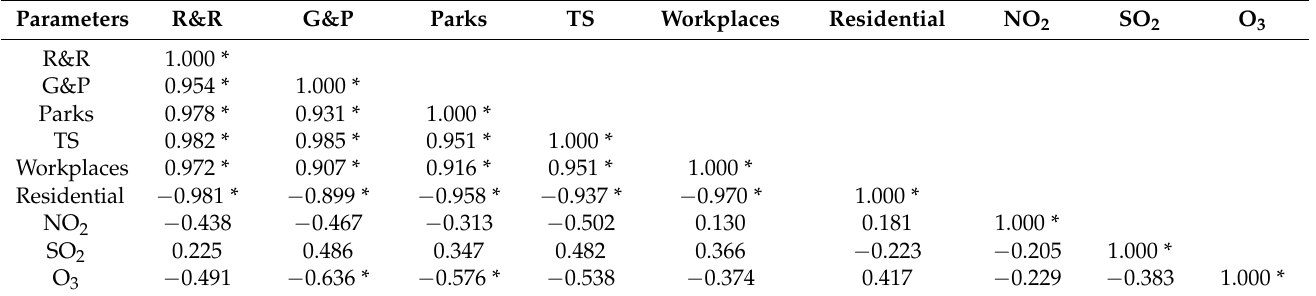
Table 3. Results of Pearson correlation ( ρ ) with Urban mobility and Air pollutants.